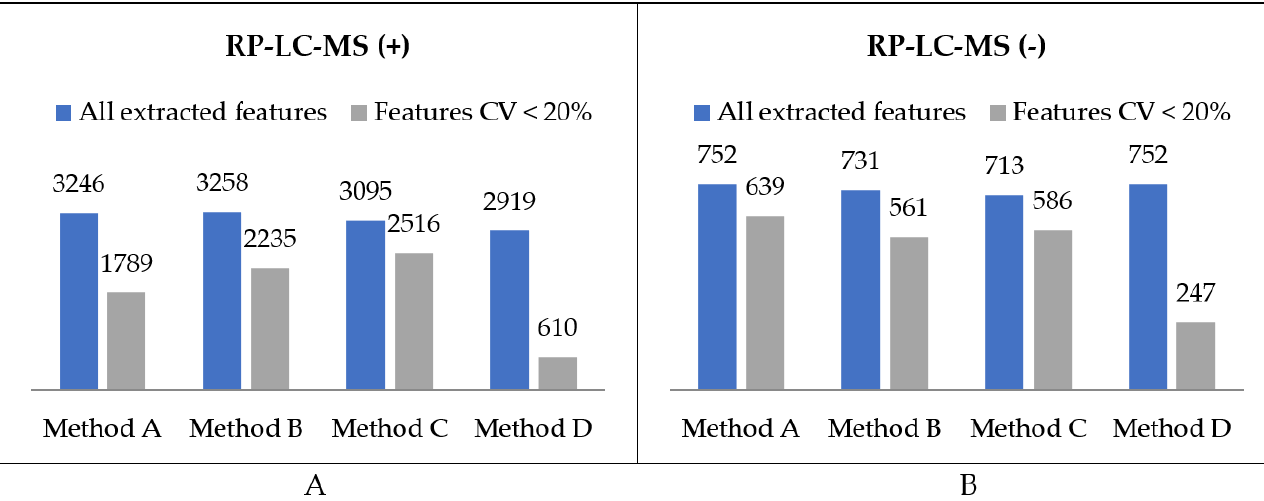
Figure 4. Summary of the number of features detected in organic extracts using RP-LC-MS in ( A ) positive and ( B ) negative ionization modes.